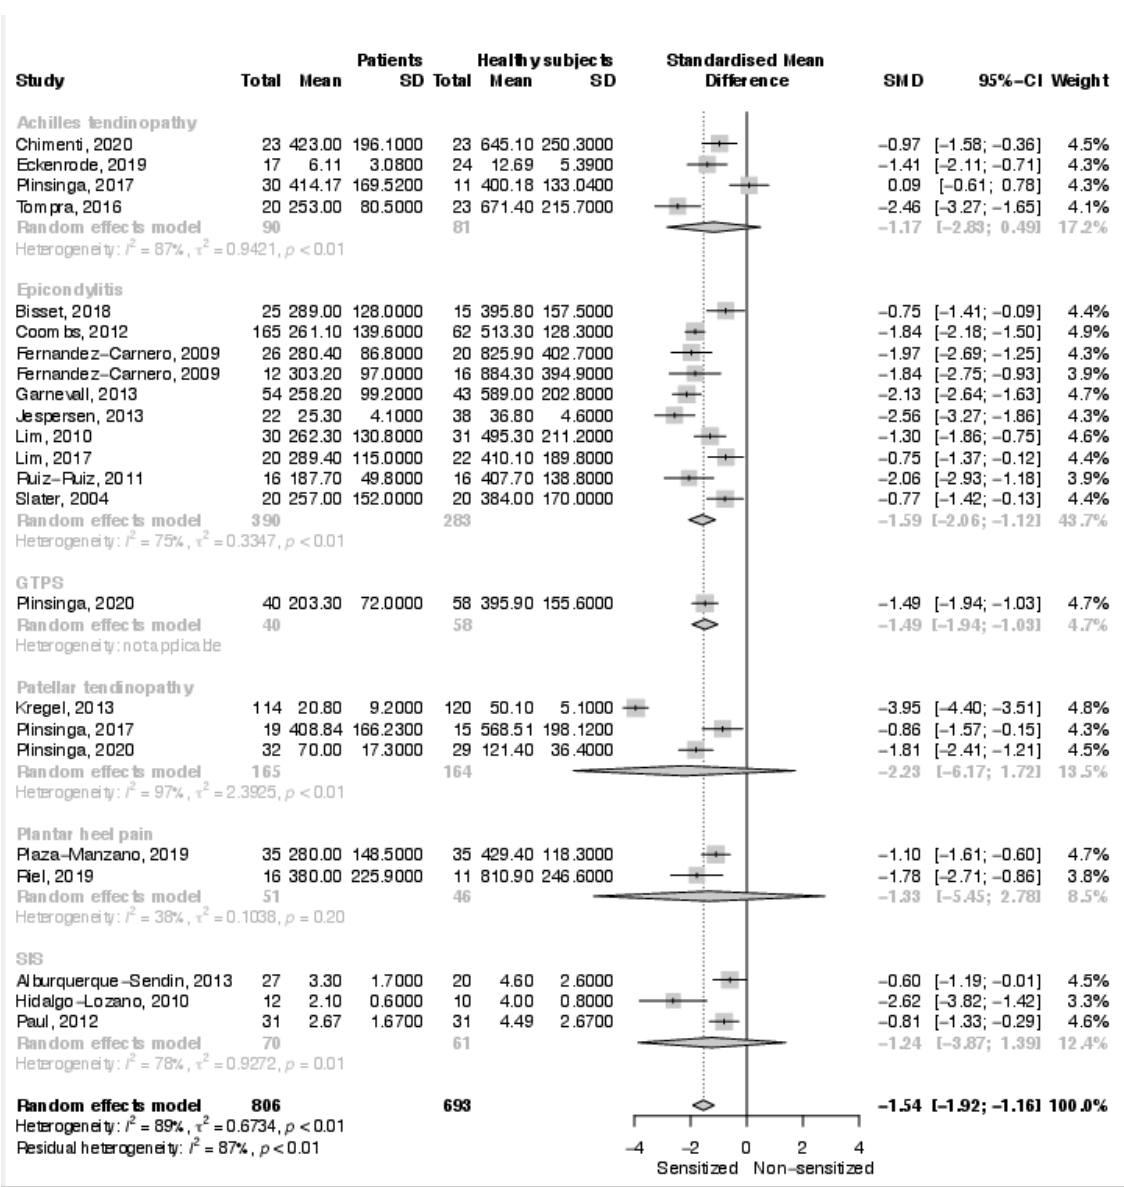
Figure 2. Results of the meta-analysis on local pressure pain thresholds. The overall analysis on HPTs found no difference between healthy and affected sub- jects with only the study of Coombes et al. documenting an increased sensitivity in pa- tients with epicondylalgia and the study of Eckenrode et al. documenting an increased sensitivity in patients with Achilles tendinopathy [22,23]. No significant difference was documented in all sub-analyses based on the specific tendinopathy (Figure 3). A signifi- cant difference (SMD: 0.47; 95% C.I. 0.21, 0.72; p < 0.001), indicating an increased sensitivity in affected subjects, was found in the meta-analysis evaluating CPTs with the studies of Coombes et al. and of Ruiz-Ruiz et al., both documenting an increased sensitivity to cold stimuli in subjects with epicondylalgia, and the study of Plinsinga et al. documenting an increased sensitivity in the subjects affected by greater trochanter pain syndrome [22,38,41]. The sub-analysis on lateral epicondylalgia and on greater trochanter pain